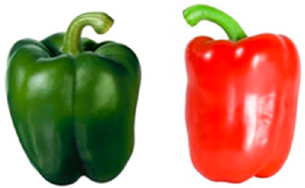
Figure 1. Sweet pepper ( Capsicum annuum L.) fruit at distinct maturation stages (fully green and fully red).